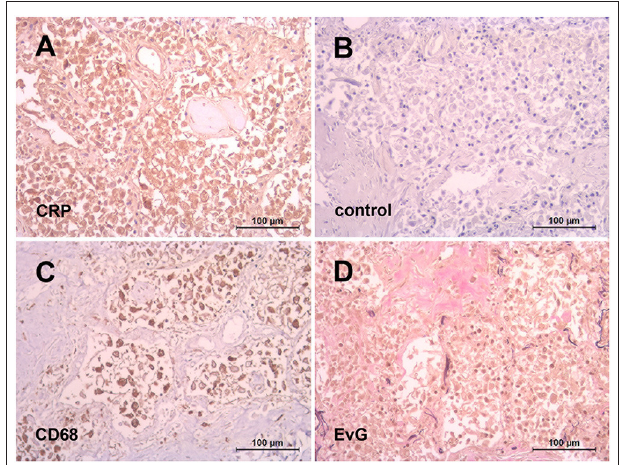
tissue from a patient died of COVID-19. Diffuse alveolar damage with intensive positive CRP staining (monoclonal antibody (mAb) clone CRP-8, Sigma) of macrophages as identified with mAb against CD68 (clone PG-M1, Dako) (A,C) . Negative control with an irrelevant isotype-matched mAb (FLEX, Dako) (B) . Interstitial pulmonary fibrosis illustrated by Elastica-van Gieson stain (D) .